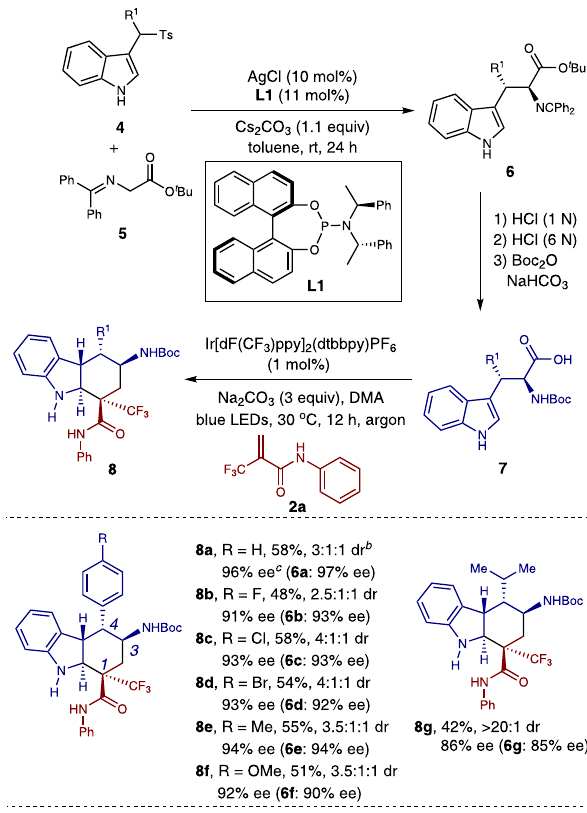
Fig. 3 Diastereoselective syntheses of chiral trans -fused hexahydrocarbazoles with fi ve contiguous stereogenic centers. a Reaction conditions: 1 mol% of Ir[dF(CF 3 )ppy] 2 (dtbbpy)PF 6 , 0.1 mmol of 2 , 0.15 mmol of 7 and 0.3 mmol of Na 2 CO 3 in DMA (2.0 mL) for 12 h